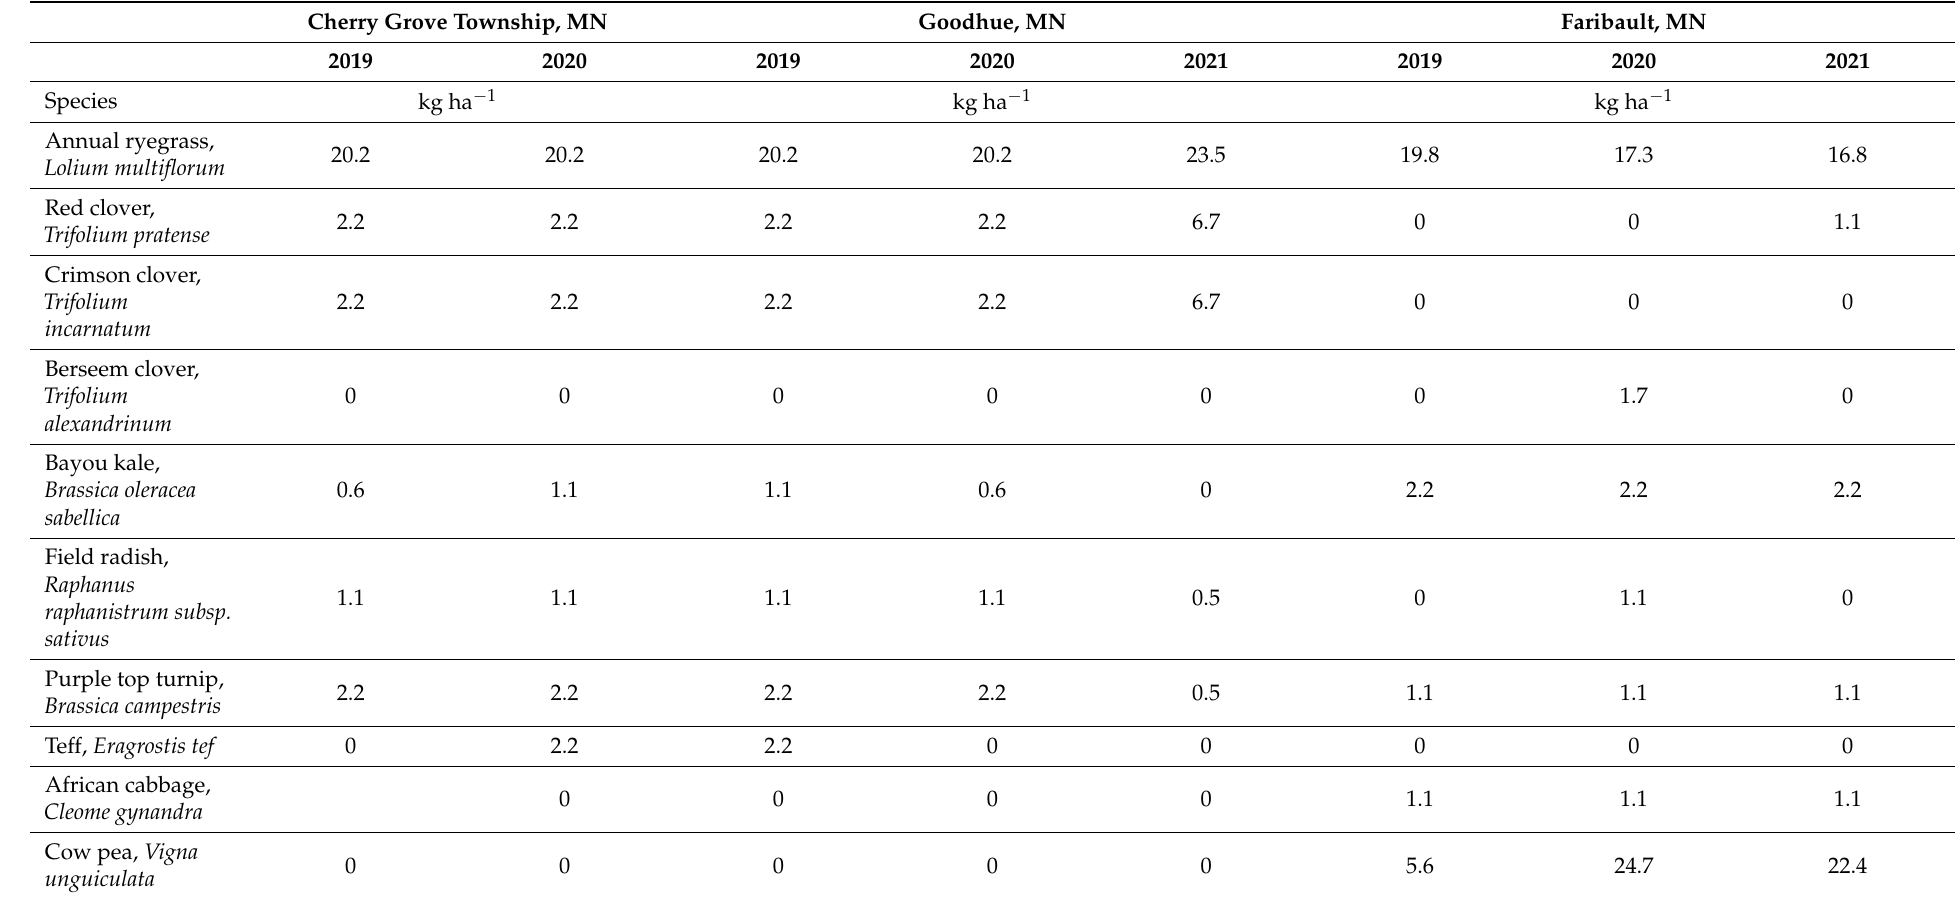
Table 4. Cover crop species mixture at each experimental site in the Goodhue and Rice Counties, MN,